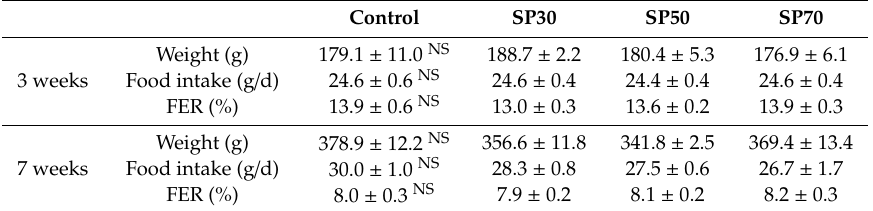
Table 4. Body weight, food intake, and food e ffi ciency ratio of the rats fed with